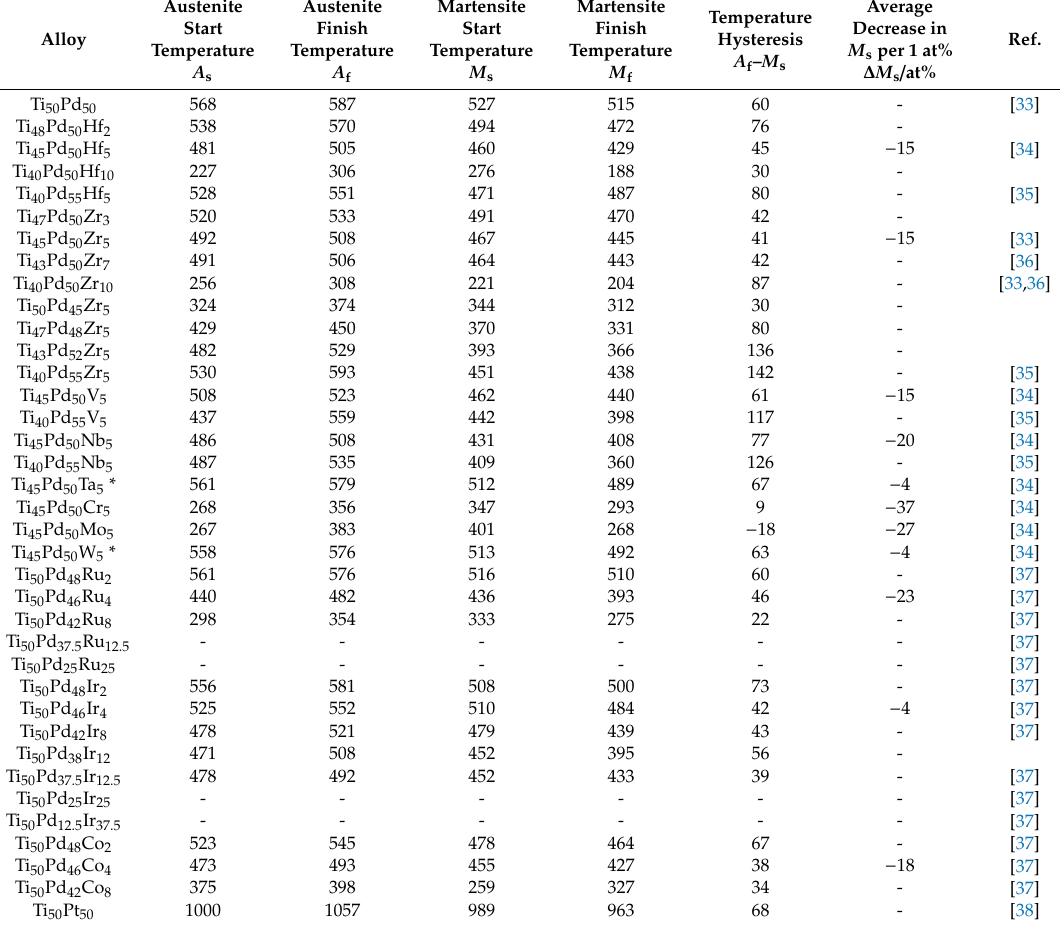
Table 1. Martensitic transformation temperature of ternary alloys ( ◦